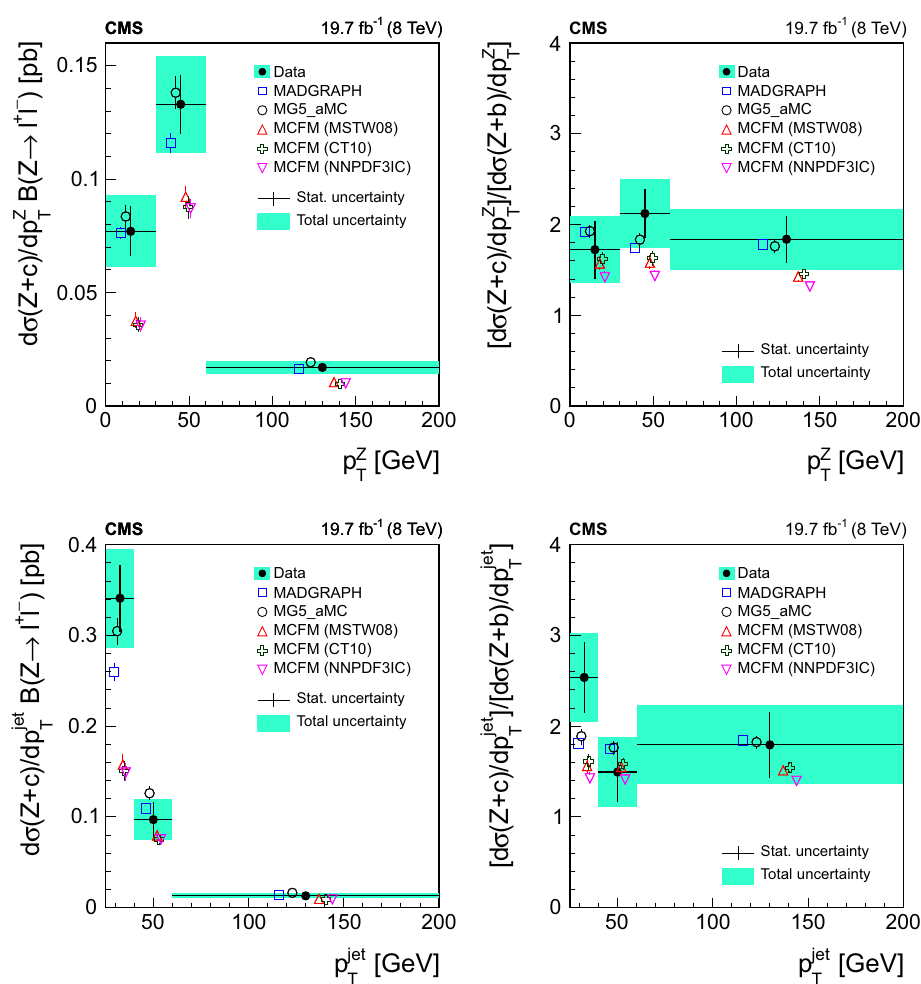
Fig. 11 Differential Z + c cross section and ( Z + c )/( Z + b ) cross sec- tion ratio as a function of the transverse momentum of the Z boson (top) and the transverse momentum of the jet (bottom). The combination of the results in the dielectron and dimuon channels is presented. The Z + c differential cross section is shown on the left and the ( Z + c )/( Z + b ) cross section ratio is on the right. Statistical uncertainties in the data are